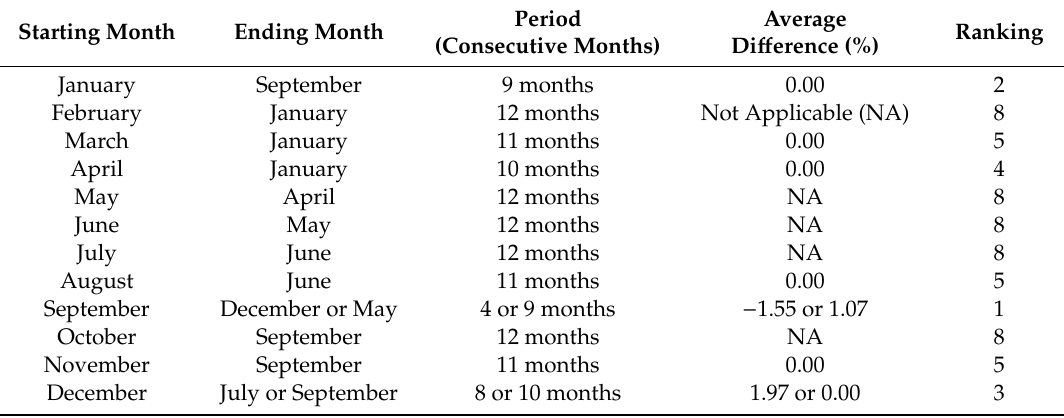
Table 6. Results from the ranking analysis for the heating change-point coefficient ( 𝑇 ℎ.𝑝. ).